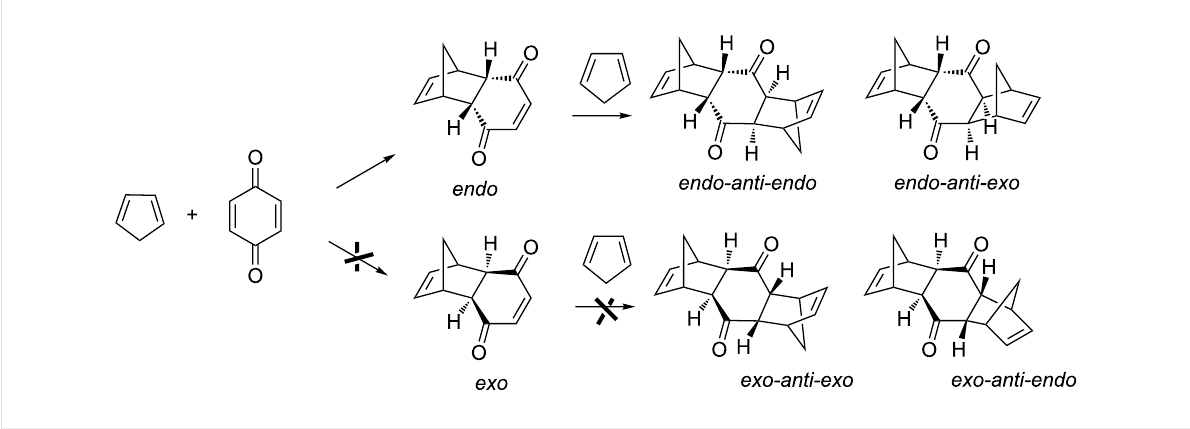
Scheme 1: Distribution of products in the Diels–Alder reaction between cyclopentadiene and p